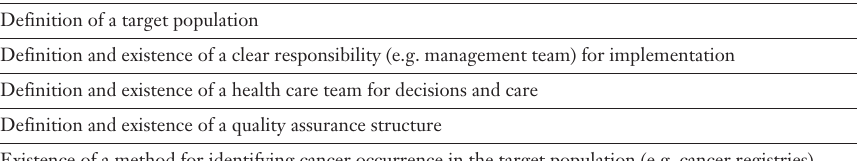
Features of organised screening pro- grammes (adapted from [9] p.